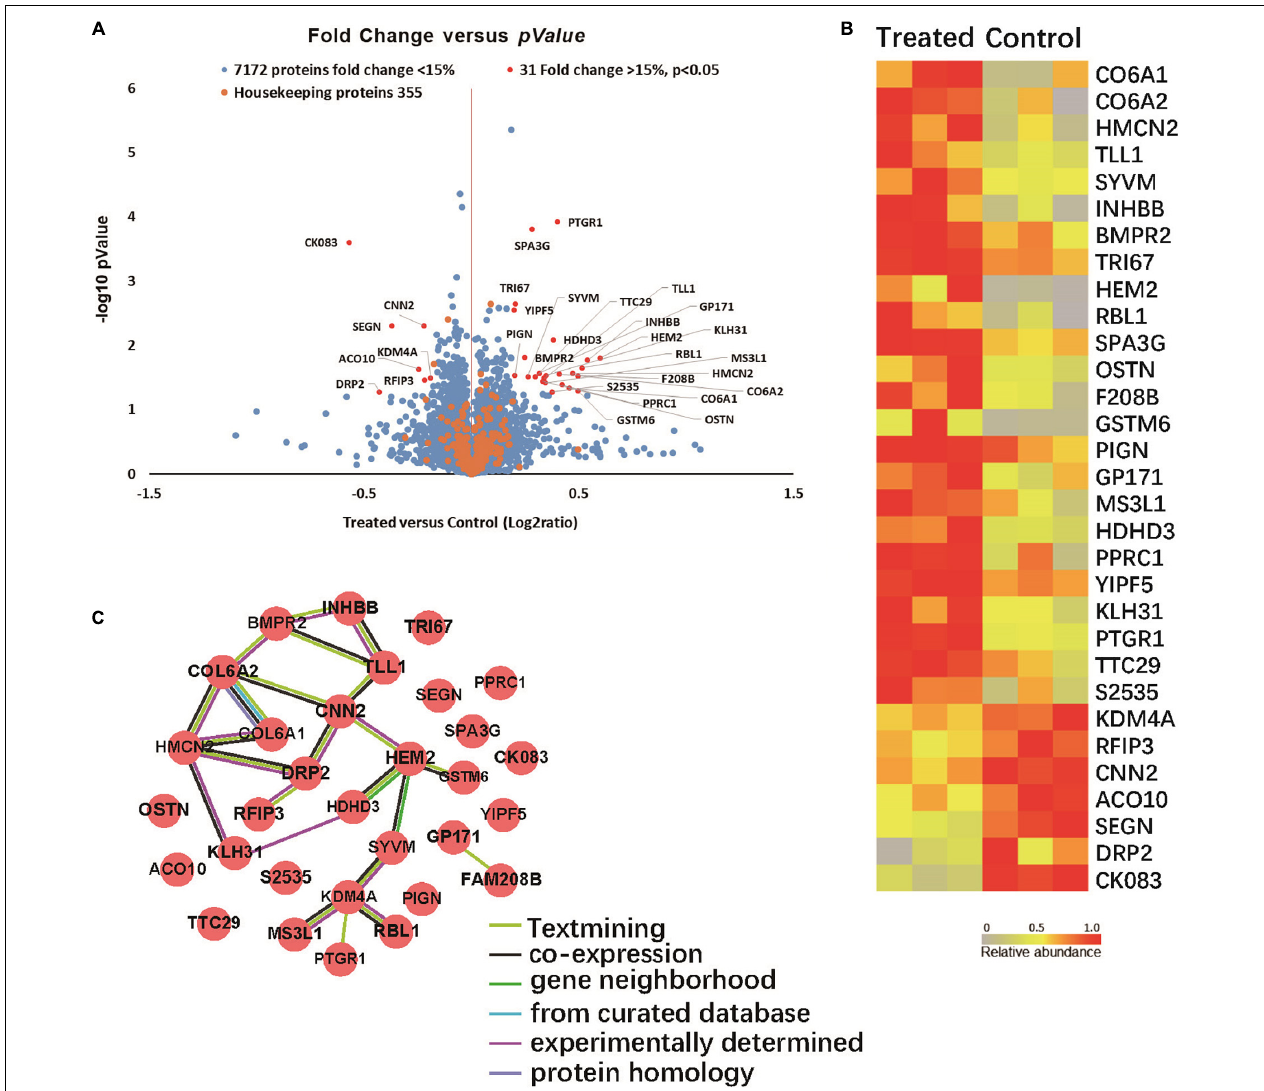
FIGURE 5 | (A) Volcano plot demonstrating the fold change of 7558 protein abundance between treated group and control group ( n = 3). The x -axis represents the log2 of fold changes (treated versus control), and the y-axis represents the statistically significant p -value (–log10 of p -value, n = 3). Blue dots represent 7172 protein fold change < 1.15, Red dots are 31 proteins fold change > 1.15, p > 0.05, and Orange dots represent 355 housekeeping proteins. (B) Proteomic characterization of the proteomes of 6 mice brain tissue samples by TMT-7plex labeling based quantitative proteomics. A heat map showing the relative abundance of 31 ranked proteins (Ratio of Treated to Control ≥ 1.15 or ≤ 0.87, p < 0.05, n = 3) was identified across two groups of 6 samples. The color key indicates the relative abundance of each protein (0 to 1.0) across 6 samples. (C) Protein-protein interaction networks. (31 items (mouse) - STRING interaction network